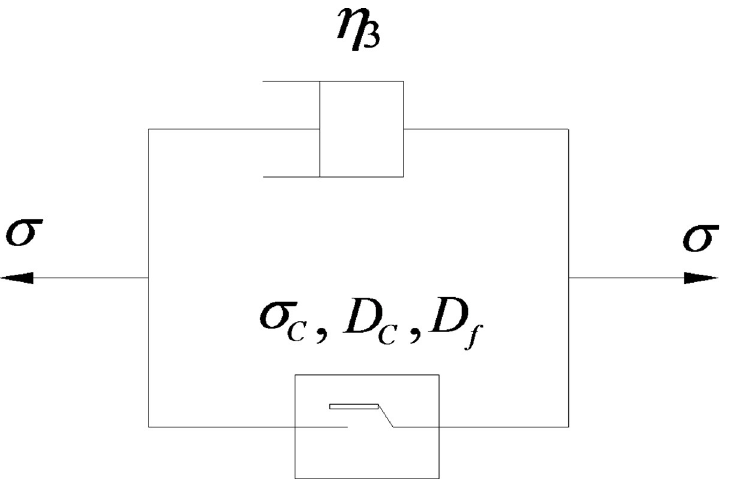
Fig 6. D-NVP volume